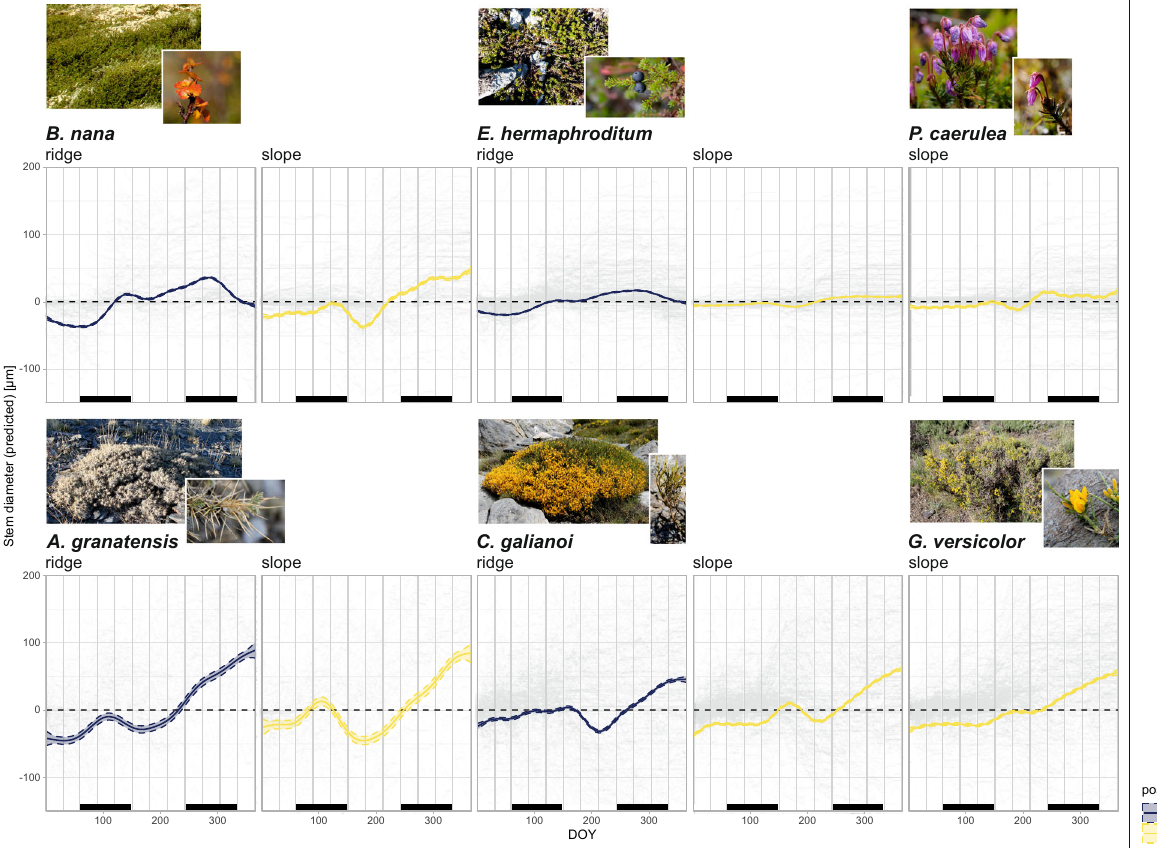
Fig. 5 Intra-annual stem diameter change predicted by generalized additive models (GAMs). Grey dotted curves show daily means of measured stem diameter change in relation to the start of the year for all individual dendrometers. Coloured lines show modelled stem diameter change from these raw data for the six focal species and topographical positions. Sampling site and year were included as random effects into the model. Bars at the bottom of each graph show meteorological seasons. Coloured areas show the 95%-con fi dence intervals. Photos show one representative specimen of each species and were taken by the